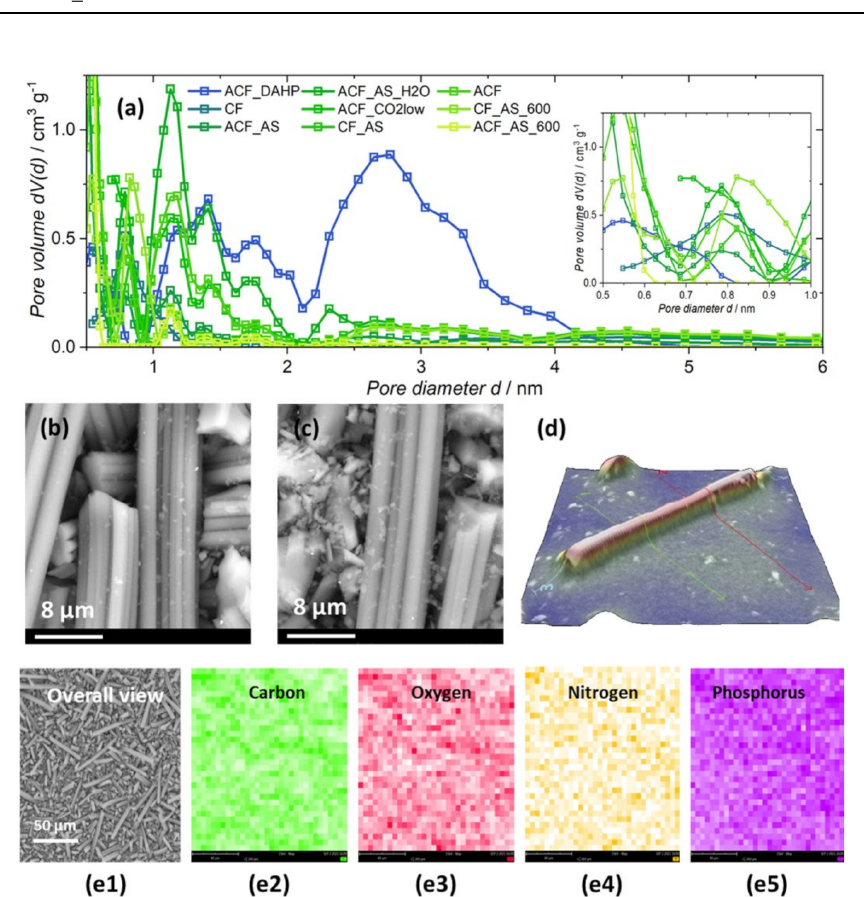
Figure 1. Top row: ( a ) pore size distribution curves for all the studied samples. Middle row from left to right: ( b ) SEM image of ACF, ( c ) SEM image of ACF_AS (field of view was 26.9 µ m in both cases), and ( d ) 3D reconstructed single fiber of the sample ACF_AS_H 2 O. Bottom row: ( e1 ) low-magnification image of ACF_AS_H 2 O and the corresponding elemental maps obtained with EDX ( e2 – e5